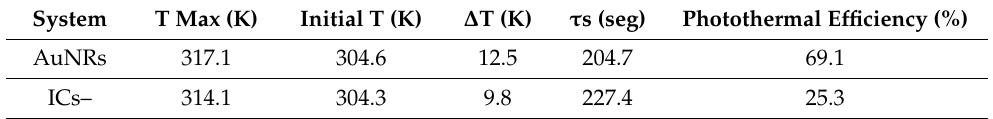
Figure A6. Increase in temperature after irradiating the AuNRs and the ICs–AuNRs systems. The ICs without AuNRs were irradiated as blank. Table A4. Photothermal efficiencies of AuNRs, ICs–AuNRs, and ICs without